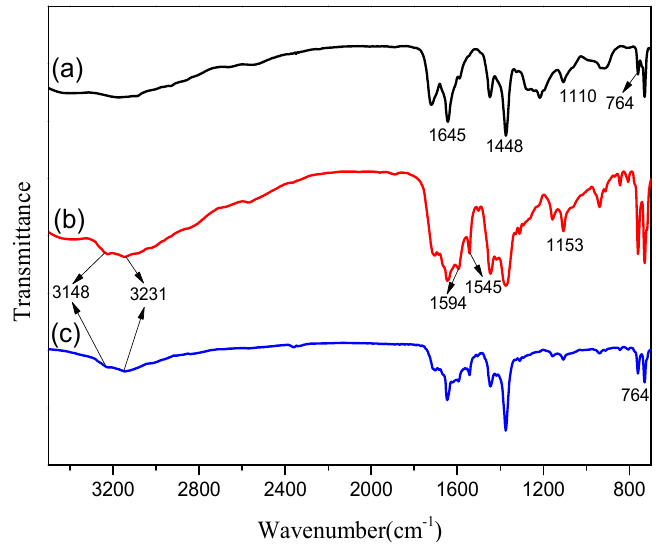
Figure 2. Fourier transform infrared spectroscopy (FTIR) spectra of ( a ) Cu-BTC, ( b ) NH 2 -Cu-BTC and ( c ) sub-NH 2 -Cu-BTC.